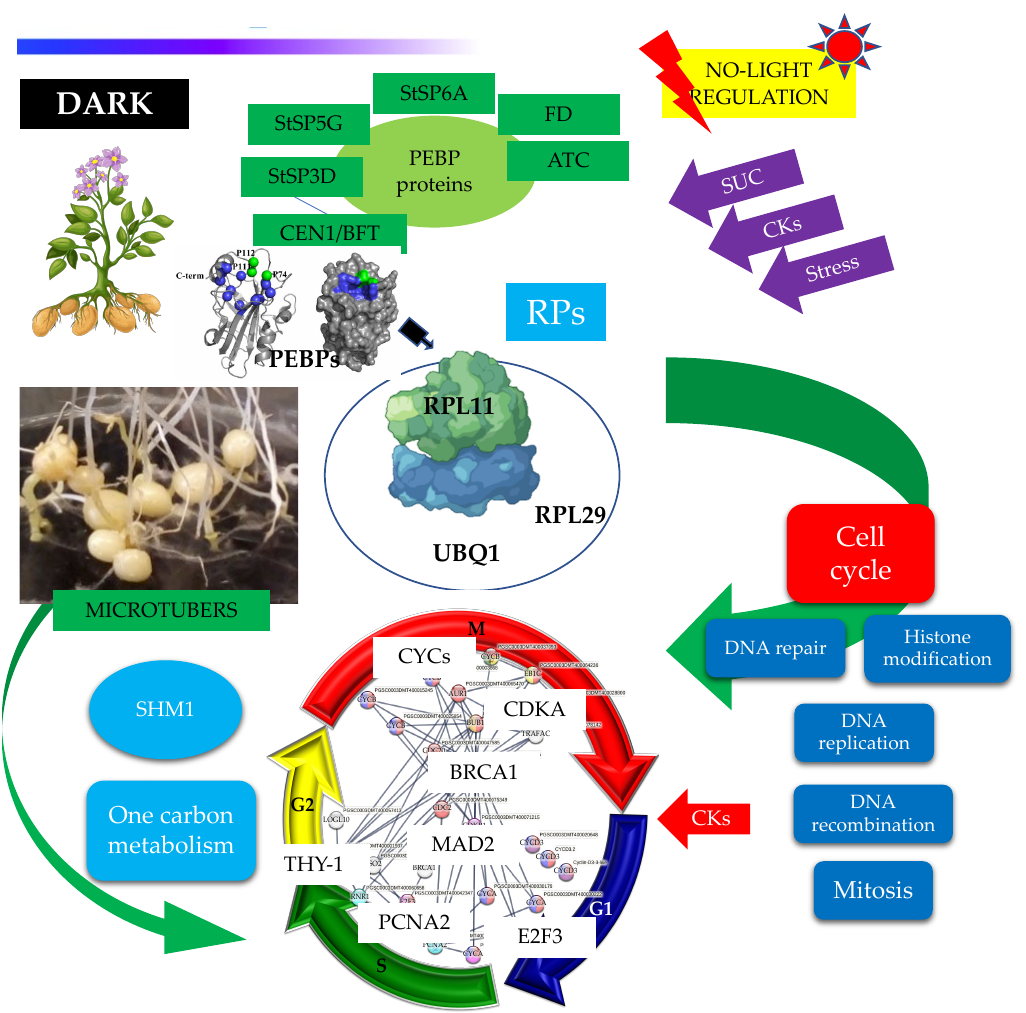
Figure 14. PPI network of up-regulated CC proteins involved in mitosis (M), S, G2, G1 phase of potato S. tuberosum from transcriptomic-wide analysis with high confidence